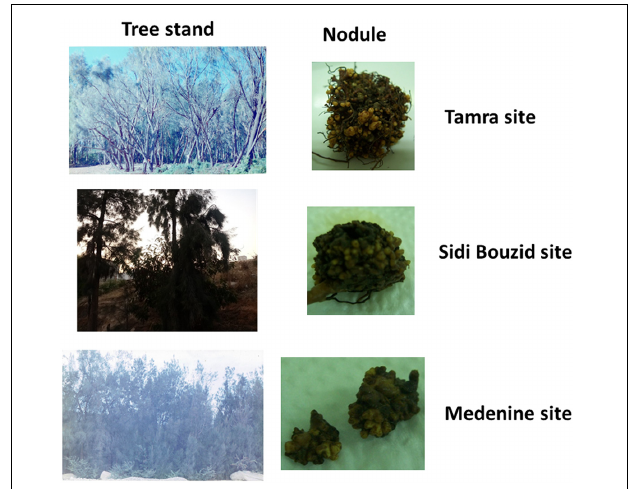
FIGURE 2 | Photograph of Casuarina tree stands at the sampling and representative nodules for those trees.